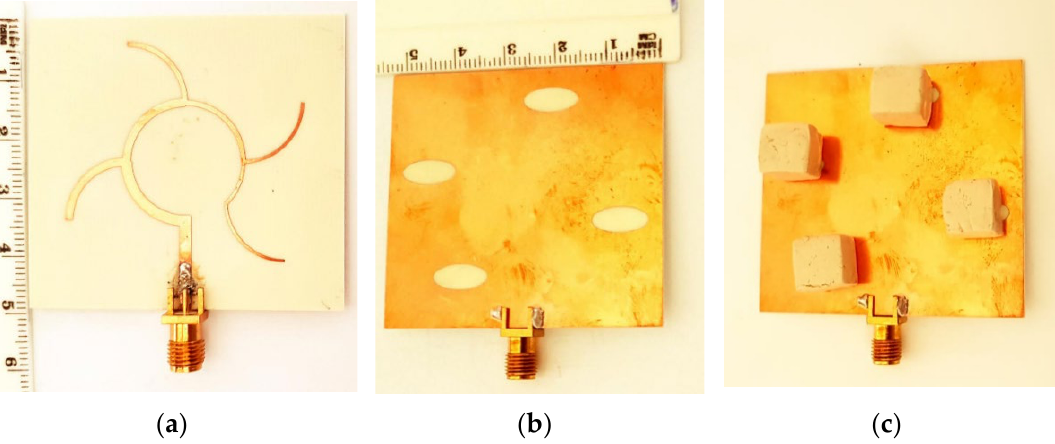
Figure 10. Photograph of the fabricated single element DRA: ( a ) The feeding network printed on the front plan; ( b ) The elliptical slots etched on the ground plan; ( c ) The dielectric resonators placed on the elliptical slots.